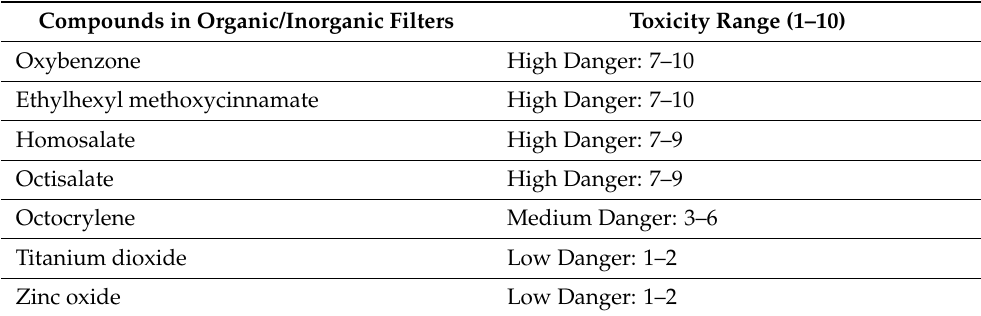
Table 3. Toxicity range of organic/inorganic filters (based on EWG’s Sunscreen Guide). Compounds in Organic/Inorganic Filters